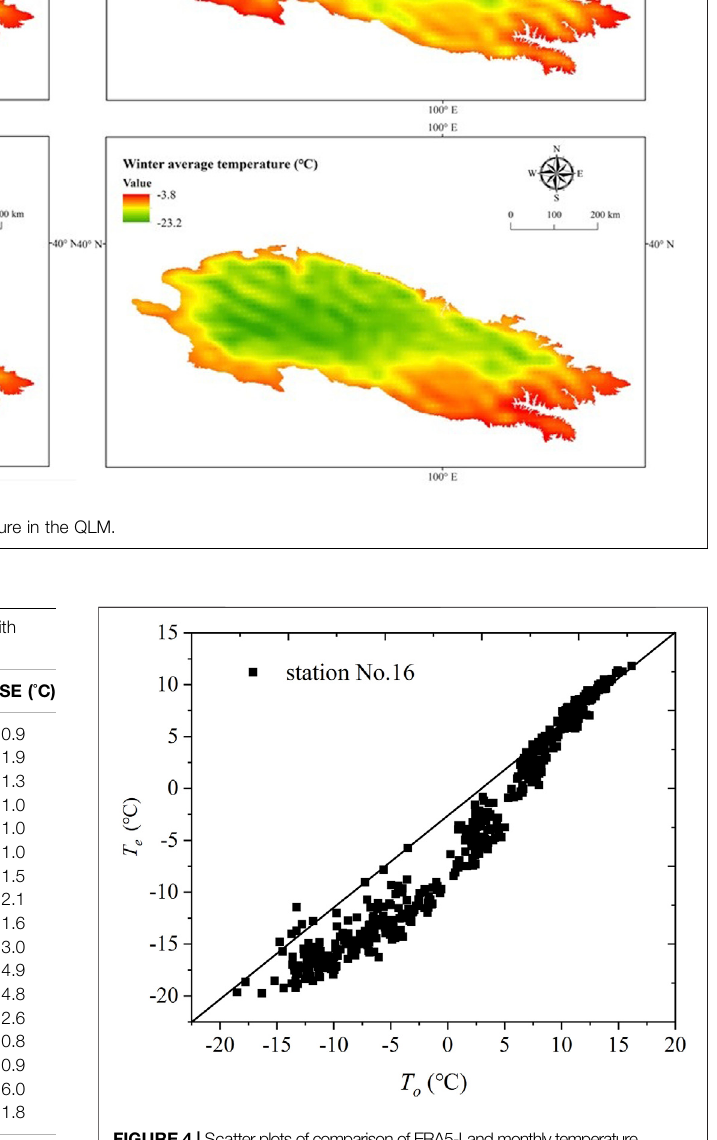
FIGURE 4 | ScatterplotsofcomparisonofERA5-Landmonthlytemperature with observations at station No. 16 in 1979 – 2017. The solid line is 1:1